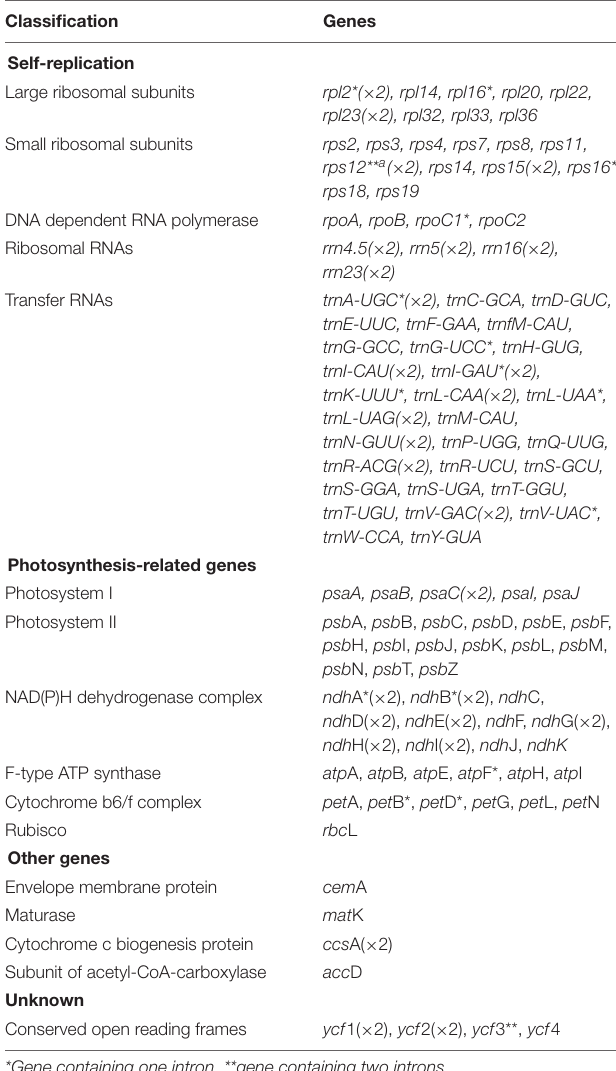
TABLE 2 | Gene contents in three Edgeworthia species chloroplast